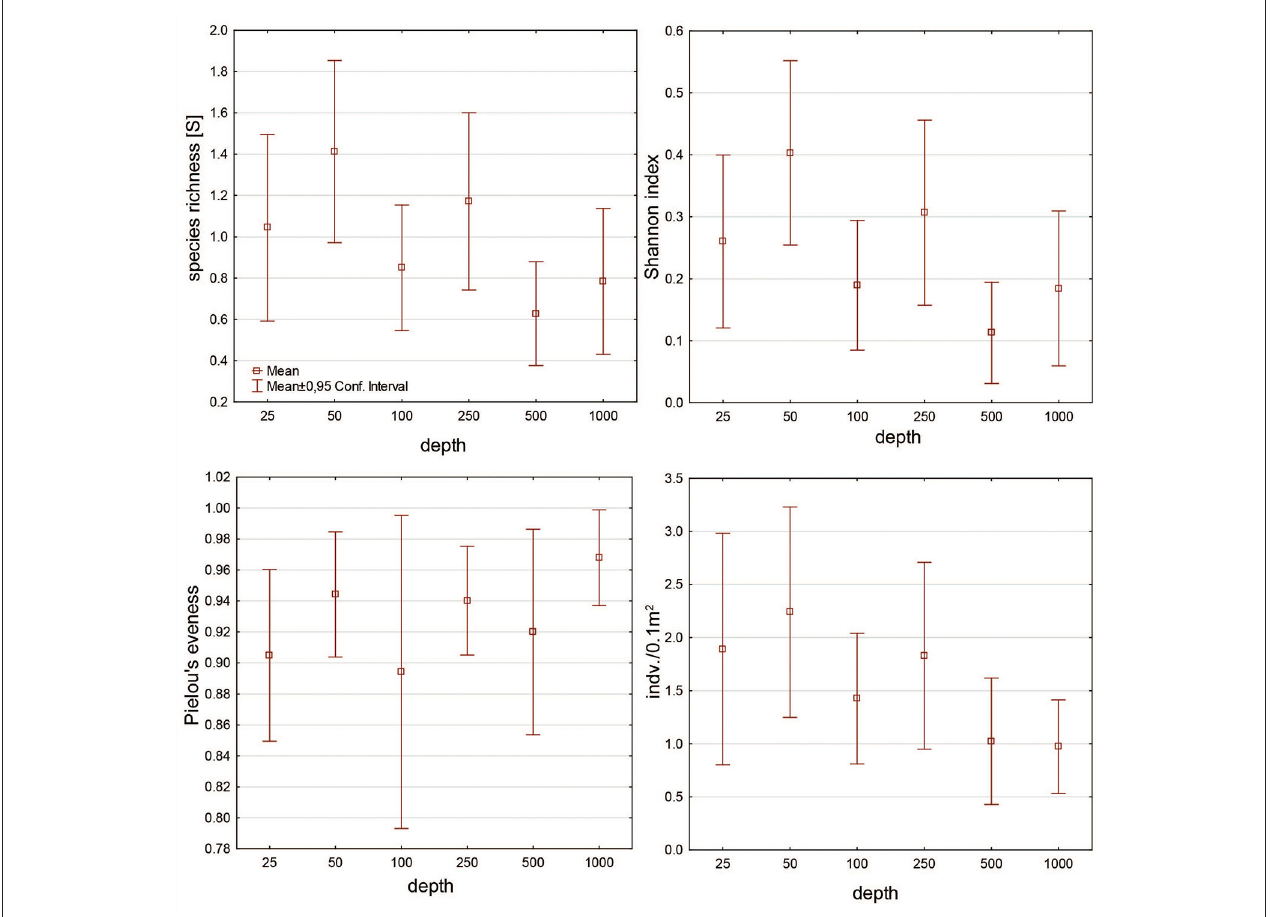
FIGURE 4 | Mean value of species richness, diversity, evenness, and abundance calculated for cumacean fauna in each depth